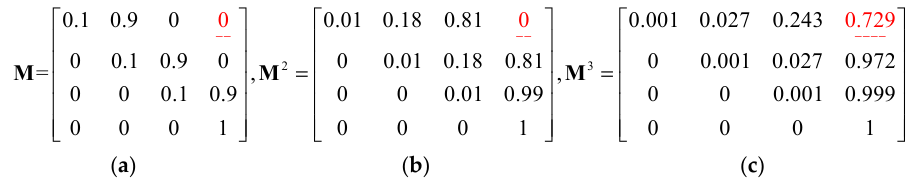
Figure 5. Transitions between locations.